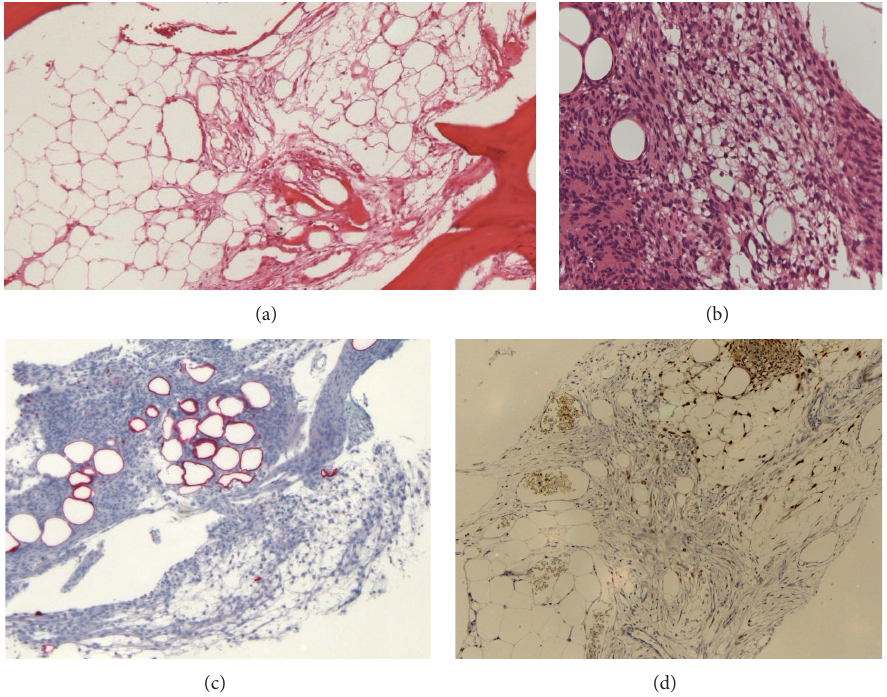
Figure 3: (a) Lipomatous meningioma with bone invasion and formation of cyst-like space (lower left). (b) Meningothelial foci interspersed with vacuolated lipomatous areas with cells resembling mature adipocytes. (c) Adipocyte-like cells stain for S100. (d) Interface between meningioma and normal fat shown by progesterone receptor staining (following decalcification